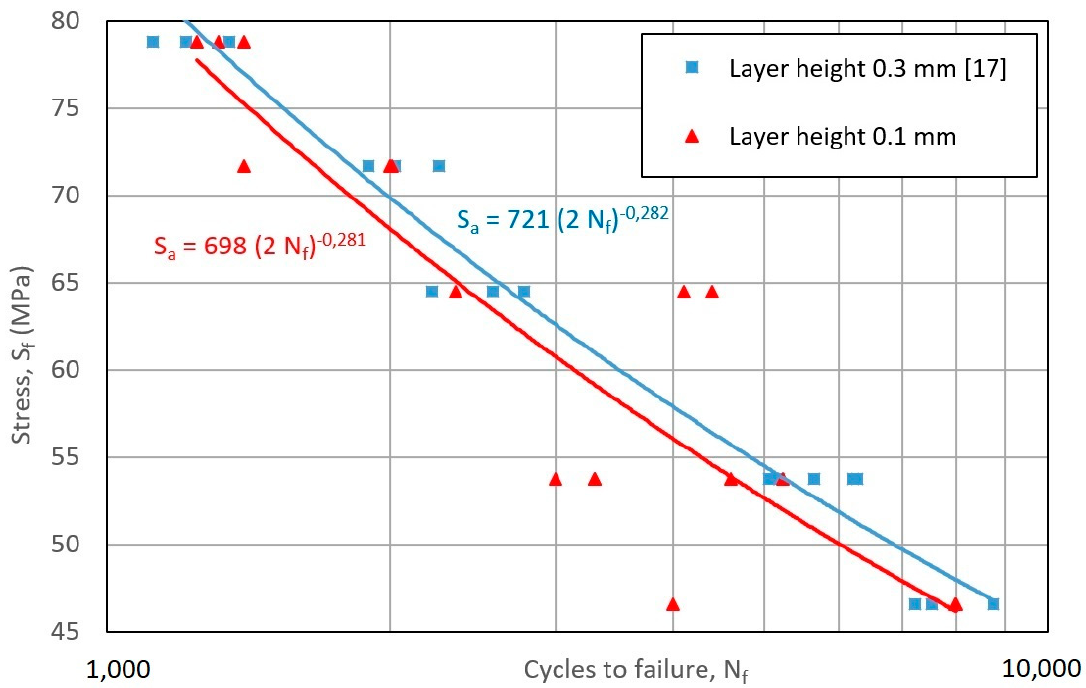
Figure 18. Wöhler curve for the results obtained in this study and those obtained in the work of [14].